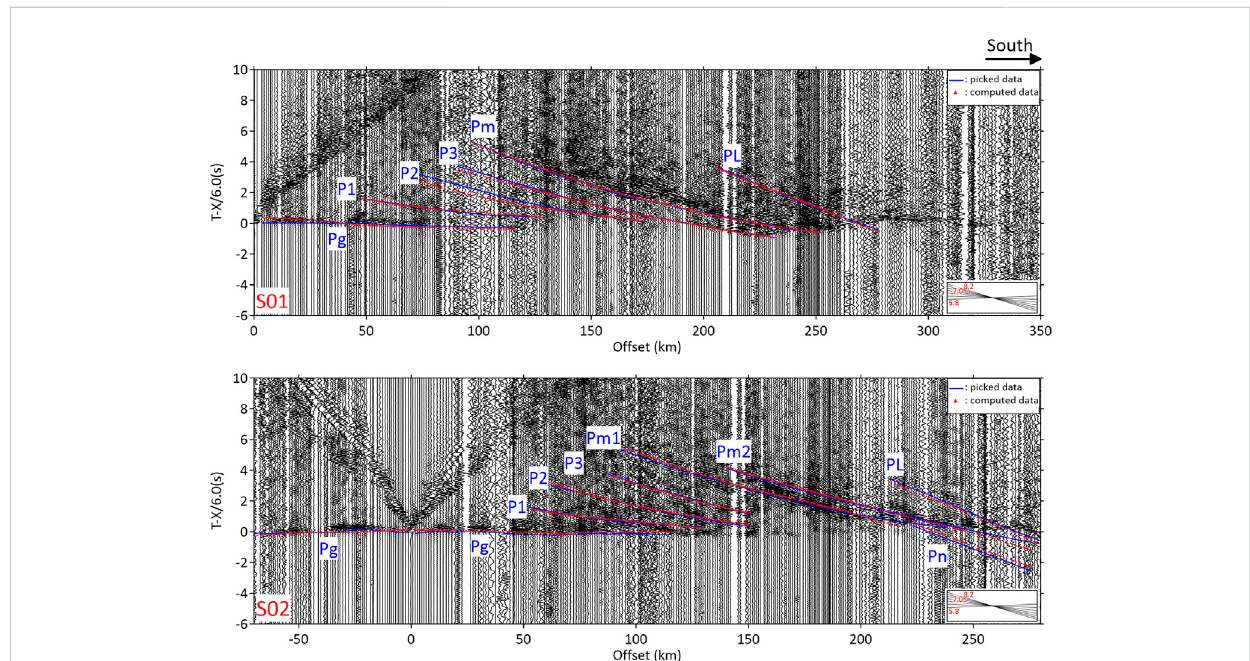
FIGURE 2 ShotgathersforshotS01andS02.TheothergathersforshotsS03-S10hasbeenincludedinthesuppmentary fi les.Shotnumberslocateatthelower left corner of each graph, and the time axis were reduced at a velocity of 6.0 km/s. Picked traveltime data are drawn as blue lines, while fi nal velocity model traveltimes are drawn as red triangles. Moreover, the slope of the lines at the lower right corner indicates the apparent velocities of the fi rst arrival phase Pg and Pn, which were labeled as red digits in the